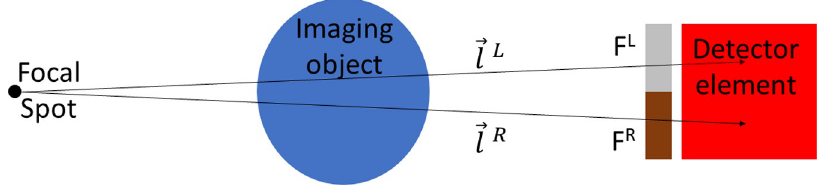
Fig 1. Sub pixel encoding divides a single detector pixel into multiple sub regions (2 sub regions are shown in this figure). Here we denote the 2 sub regions as the left and right sides of the detector pixel. A filter is denoted by F in the figure and is split into a left F L and right F R side. X-rays emanate from the source and pass through the object and strike the left or right side of the filter and detector. We denote the paths taken by rays on the left and right sides of the detector pixel as ~ l L and ~ l R